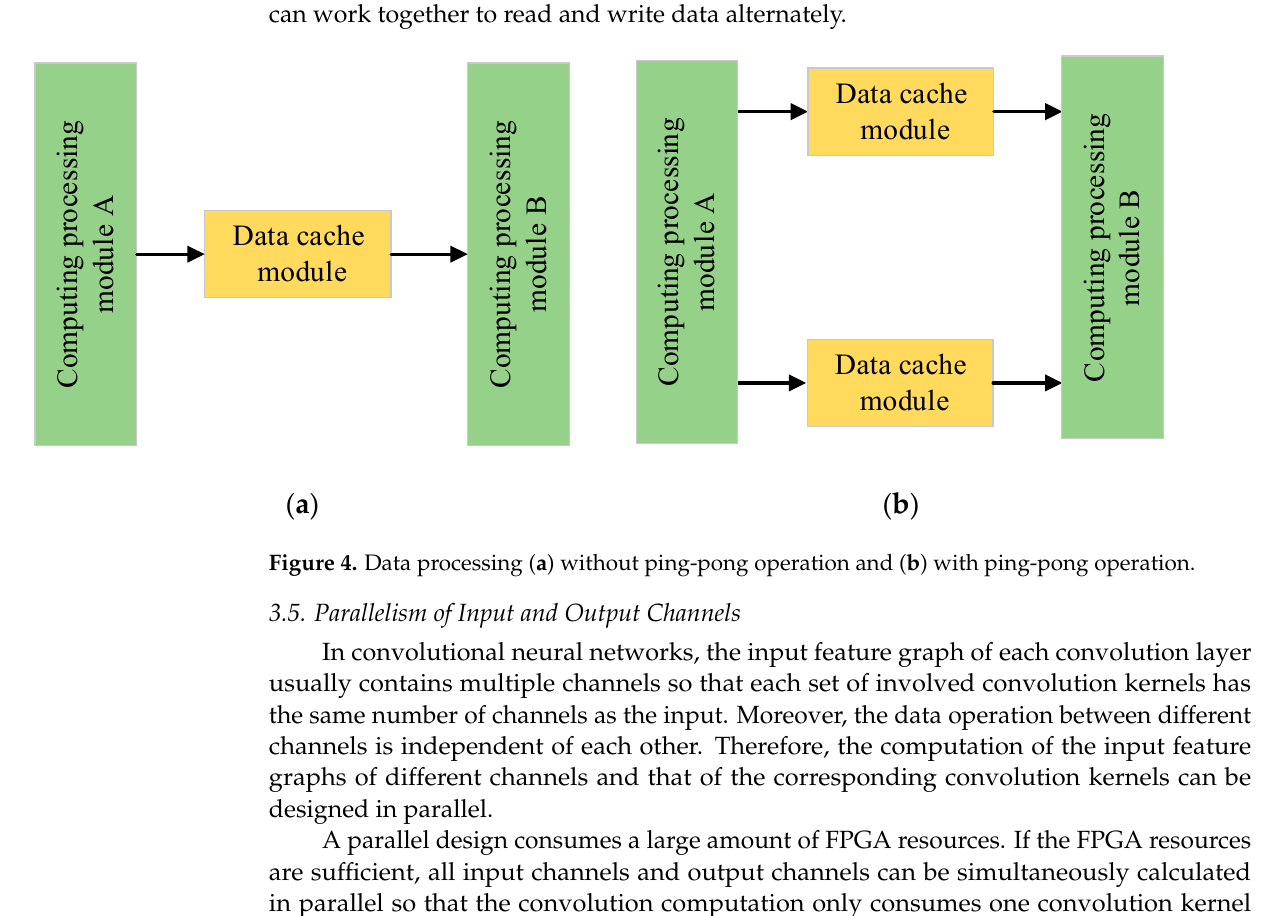
7 of 19 Figure 3. Pipeline instruction optimization structure. 3.4. Ping-Pong Operation “Ping-pong operation” is to continuously send the buffered data stream to the data processing unit through the input selection unit and the output selection unit. Therefore, it is very suitable for pipelining data processing. The ping-pong operation can reduce the delay caused by the data input and enable the low-speed module to process high-speed data streams. Two types of data processing are shown in Figure 4. When there is no ping-pong